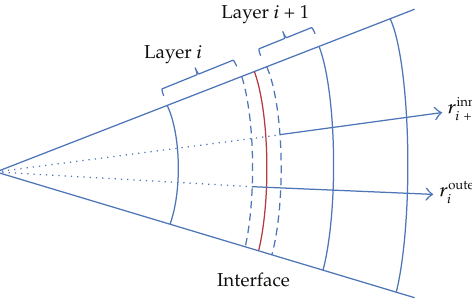
Figure 4: Constraints at layer